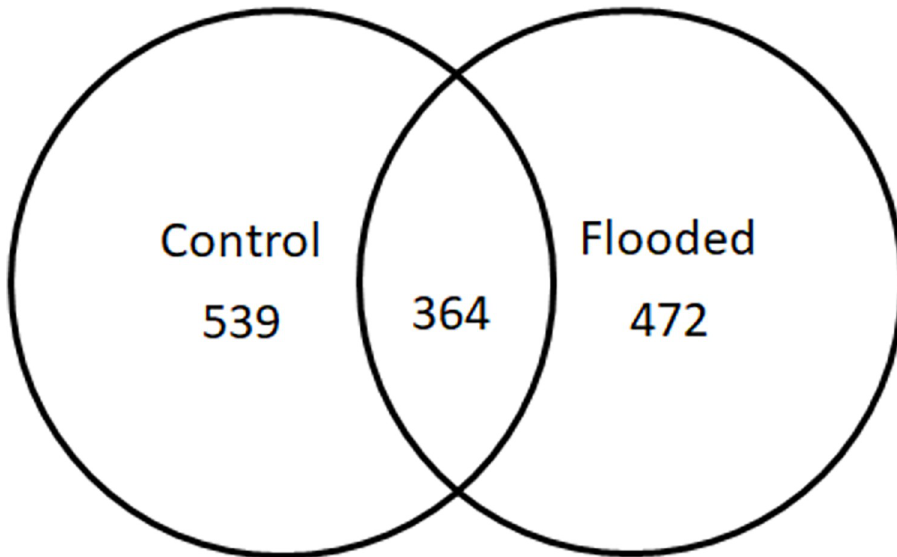
Fig 2. Venn diagram of total identified and common proteins in control and flooded soybean